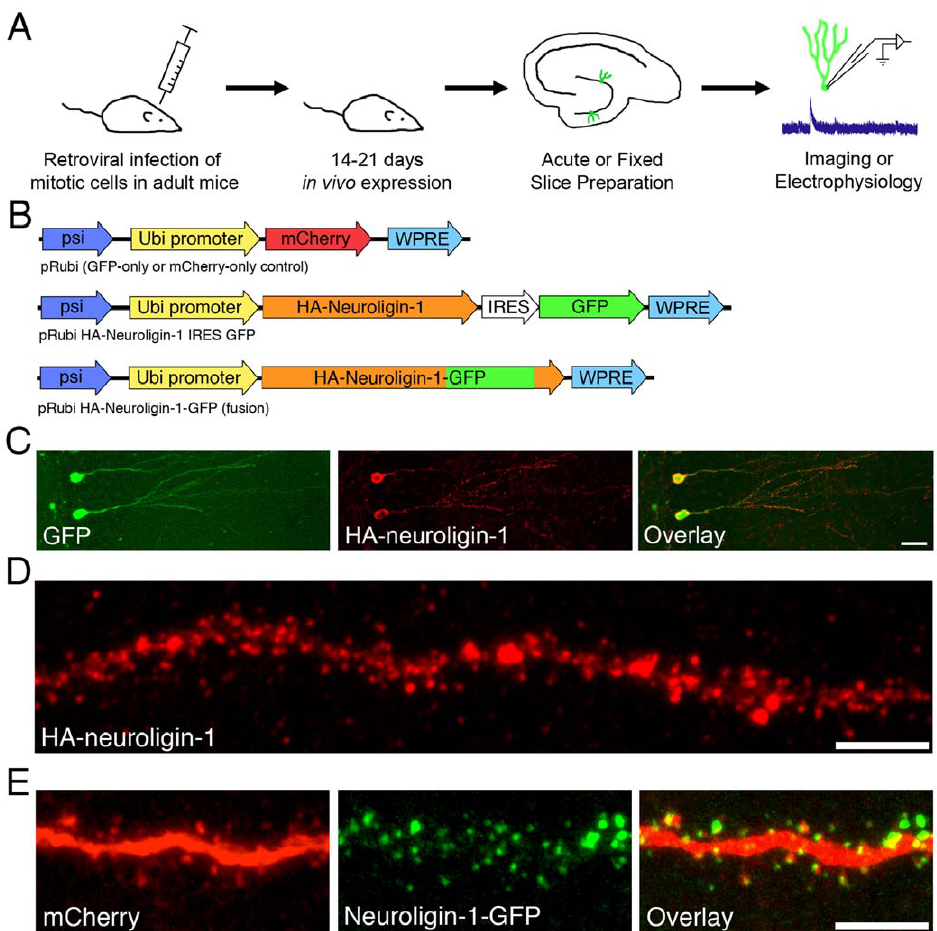
Figure 1. Retrovirus-mediated neuroligin-1 expression in newborn granule cells. A. Experimental design schematic illustrating retroviral infection of dentate stem cells in anesthetized mice, allowing in vivo cell maturation, and subsequent ex vivo imaging or recording at defined post- mitotic stages (14 or 21 dpi). B. Retroviral constructs used in this paper. The Ubiquitin promoter drives expression of control proteins (either GFP or mCherry), a neuroligin-1-GFP fusion protein, or neuroligin-1 in conjunction with GFP via an IRES sequence. All neuroligin-1 constructs also carried an extracellular HA tag. C. Newly born granule cells 21 days post-mitosis, infected with HA-neuroligin-1 IRES GFP retrovirus at day 0. Confocal stacks of anti-HA and anti-GFP stained granule cells demonstrate co-expression of exogenous neuroligin-1 and GFP. Scale bar: 20 m m. D. Higher power image of an infected granule cell dendrite stained with anti-HA antibody (red), showing the exogenous HA-neuroligin-1 expression pattern. Scale bar: 5 m m. E. High-power image of a dendritic segment from a double-infected granule cell (one retrovirus encoding mCherry to outline cell morphology, and a separate virus encoding a neuroligin-1-GFP fusion protein). Scale bar, 5 m m.